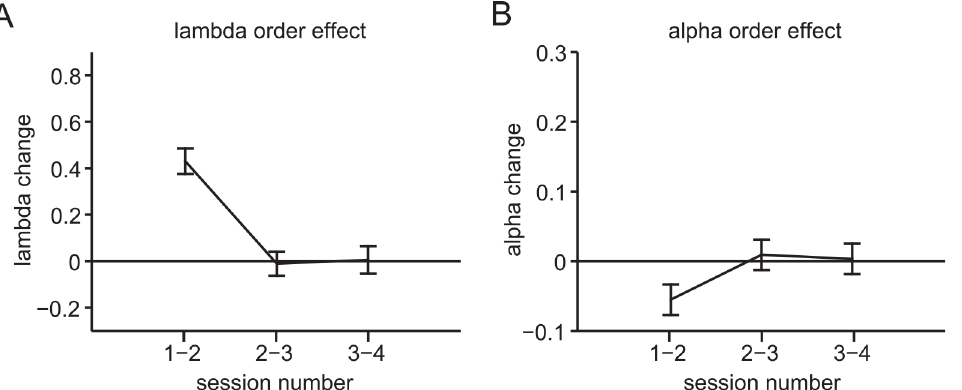
Fig 5. Session order effects. (A) Session order effects on loss aversion. Loss aversion increased from the first to second session, but remained stable for all subsequent sessions. Note that session order was randomized with regard to cycle phase. ( B) Session order effects on risk aversion. Risk aversion increased from the first to second session, but remained stable for subsequent